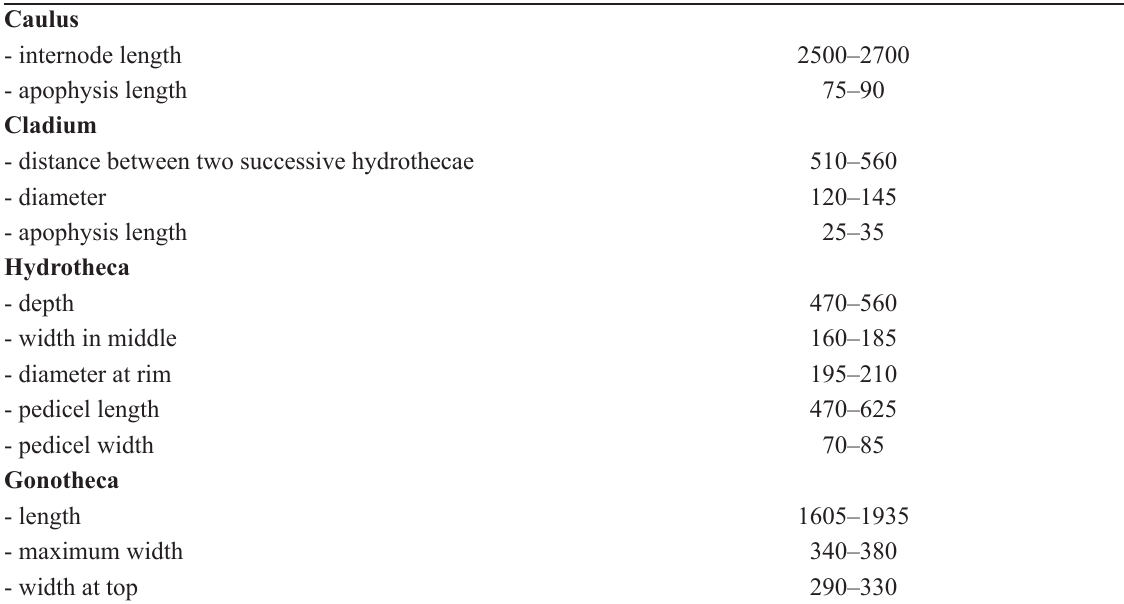
Table 13. Measurements of Zygophylax niger Galea, sp. nov., in